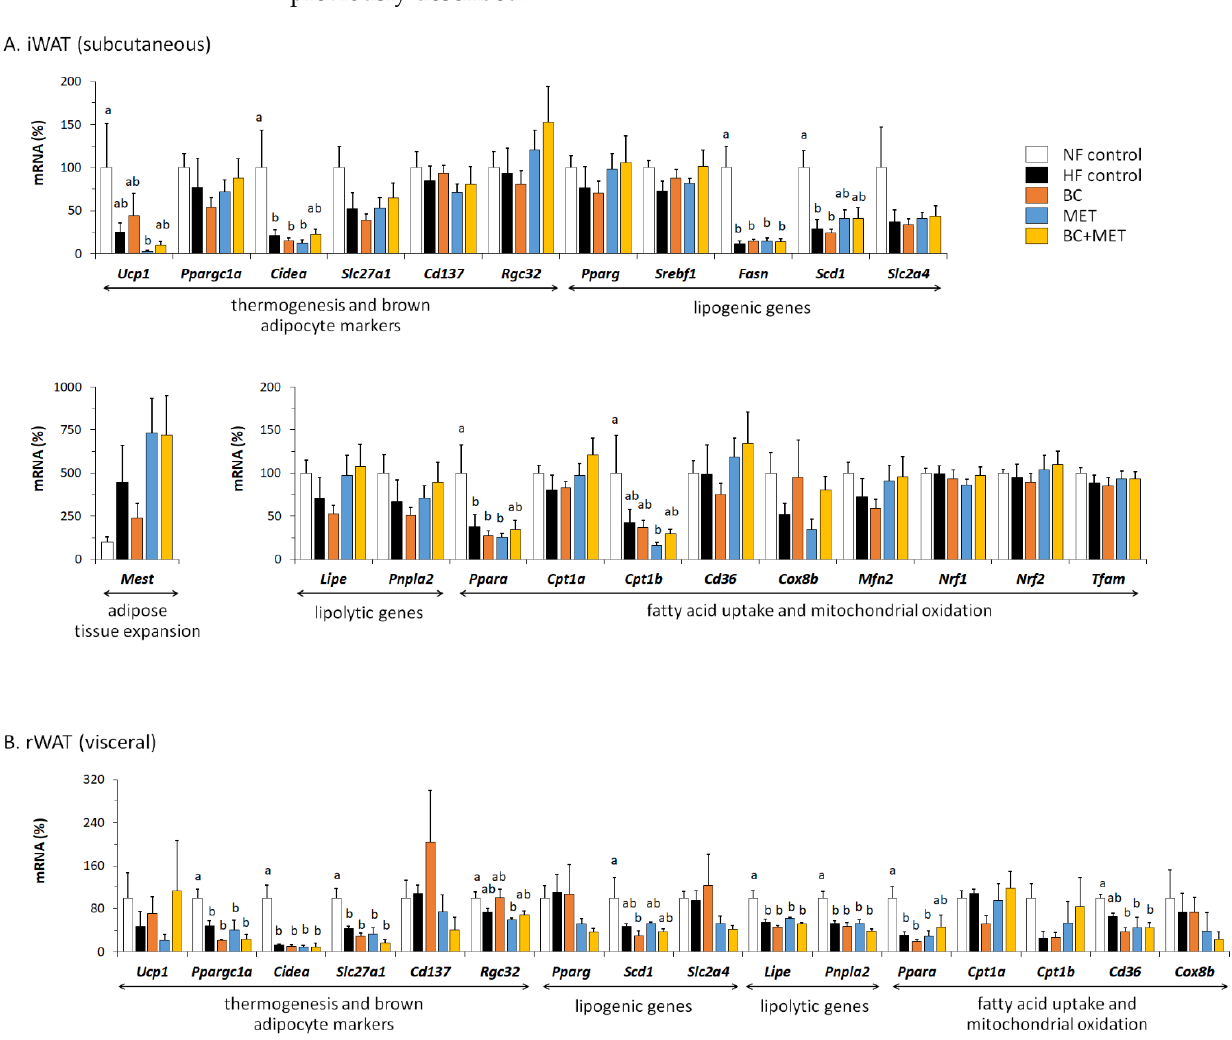
Figure 5. mRNA levels of the indicated genes in subcutaneous iWAT ( A ) and visceral rWAT ( B ) at the end of the experiment. Obesity-prone mice were challenged with a high-fat diet for 4 weeks while receiving placebo (HF control) or being treated orally with BC (3 mg/kg/day), MET (100 mg/kg/day), or their combination (BC+MET); a fifth group received placebo and was kept on a normal-fat diet (NF control). Data are means ± SEM of five to nine animals per group and are expressed relative to the mean value of the NF control group, which was set to 100. To compare between groups, one-way ANOVA followed by Tukey’s Honest Significant Difference post hoc test was used: bars not sharing a common letter (a and b) are significantly different (a (cid:54) = b) ( p <